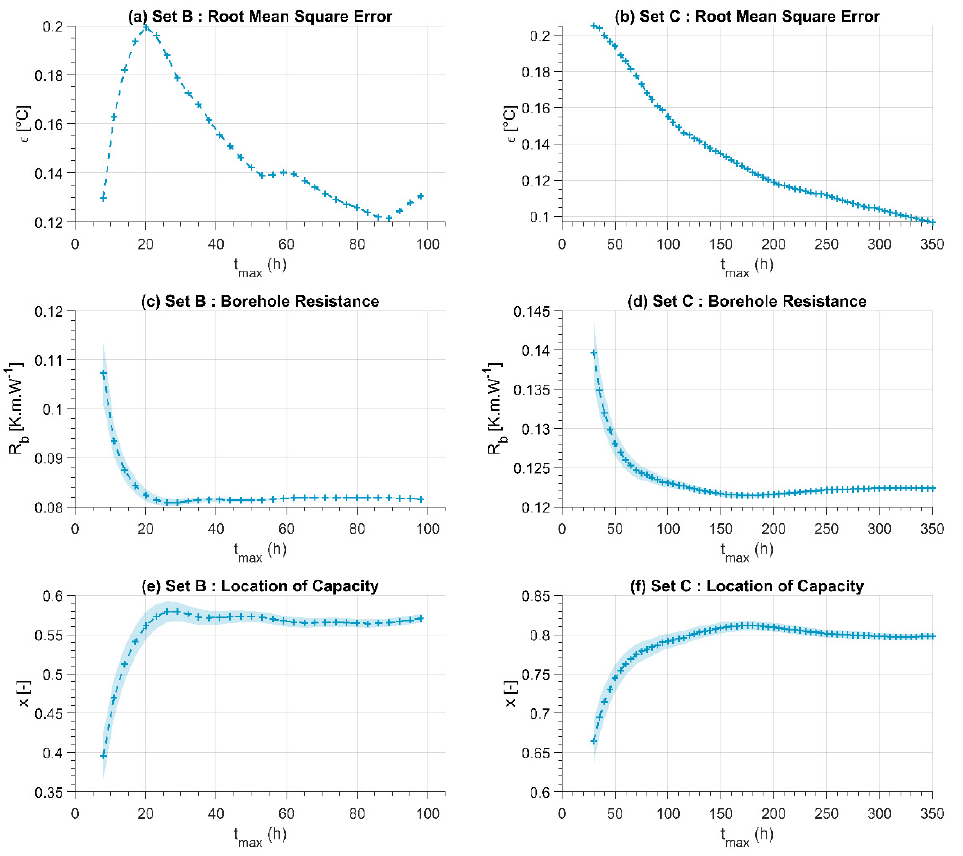
Figure 10. Interpretation of TRT with fixed λ m : values of ε , R b , x as a function of the duration of the integration t max : misfit ε for ( a ) set B, ( b ) set C; R b for ( c ) set B, ( d ) set C, x for ( e ) set B, ( f ) set C.